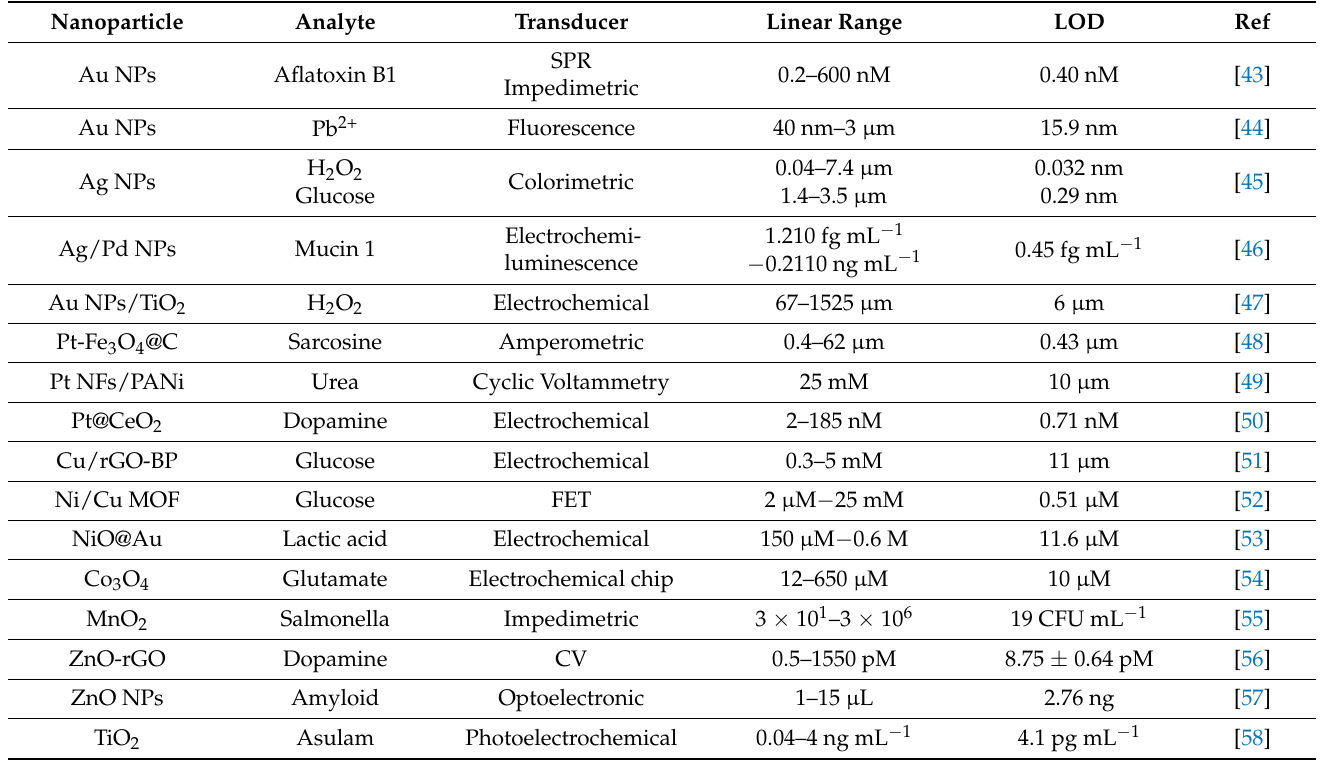
Table 2. Nanomaterials used in the development of